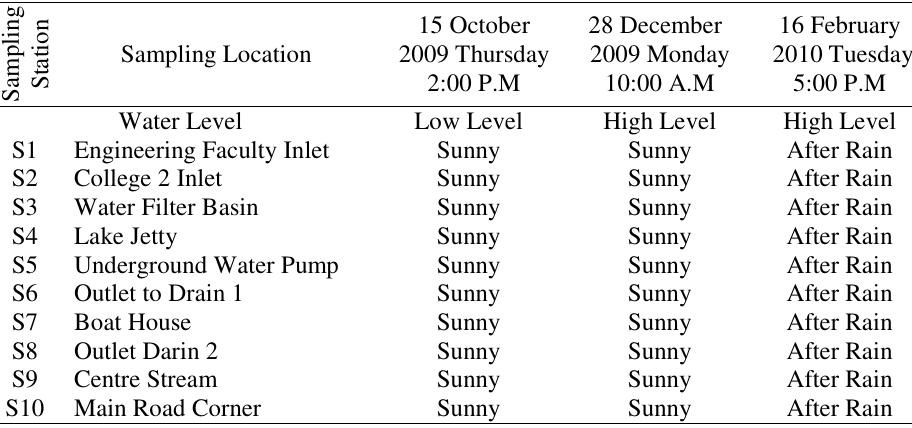
Table 1. Sampling